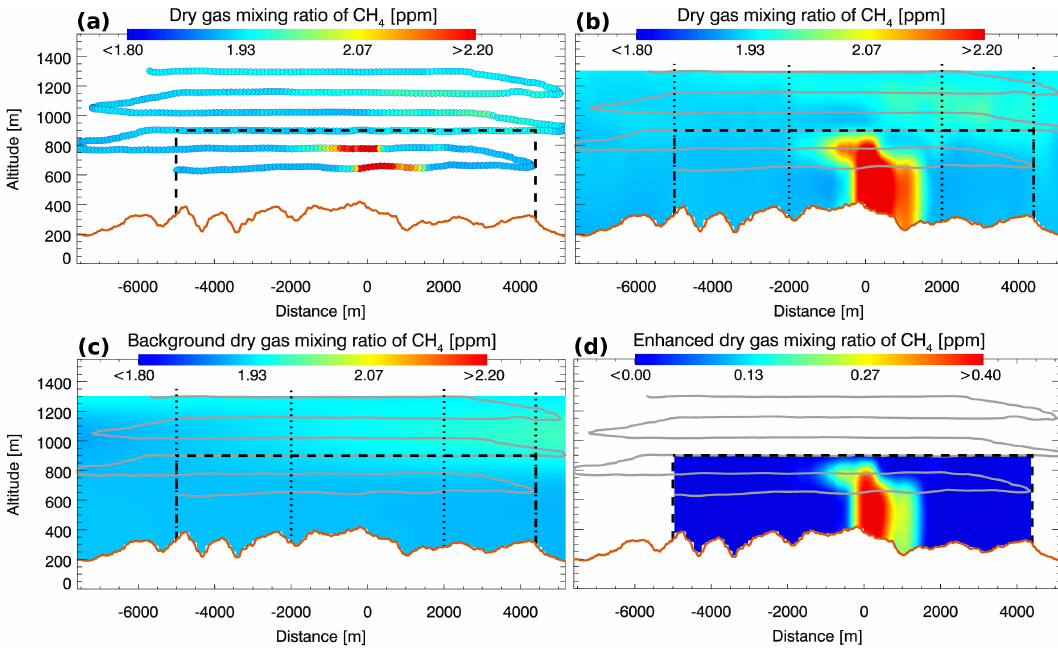
Figure 5. Example dry gas mixing ratios of CH 4 for the first downwind wall measured on 1 September 2014 (middle in situ wall in Fig. 6, solid red line). (a) Projected and time lag corrected mixing ratios acquired along the flight track onto the wall. (b) Kriged mixing ratios based on the measurements in panel (a) and an additionally added pseudo-track at the surface (not shown; see Sect. 4.2 for details). (c) Derived background mixing ratios from panel (b) . (d) Derived CH 4 enhancement (kriged mixing ratios in panel b minus background mixing ratios in panel c ). X axis gives the distance from the approximate plume center in meters and y axis gives the altitude in meters above sea level. Solid orange lines depict the surface elevation (based on SRTM) and solid grey lines the projected flight track. Vertical dotted black lines show horizontal limits, which were used to define the background area (here from − 5.0 to − 2.0km and from + 2.0 to + 4.4km). The area, which was used in the mass balance approach for estimating the emission rate, is enclosed by the dashed black